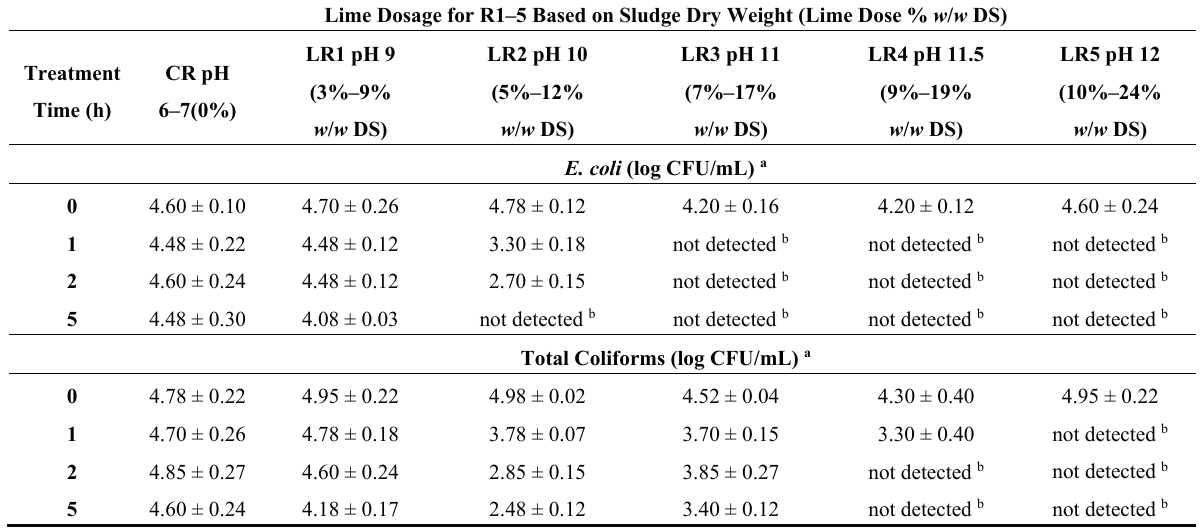
Table 4. Process monitoring of hydrated lime treatment in the field with sludges 3–6 (cf. Table